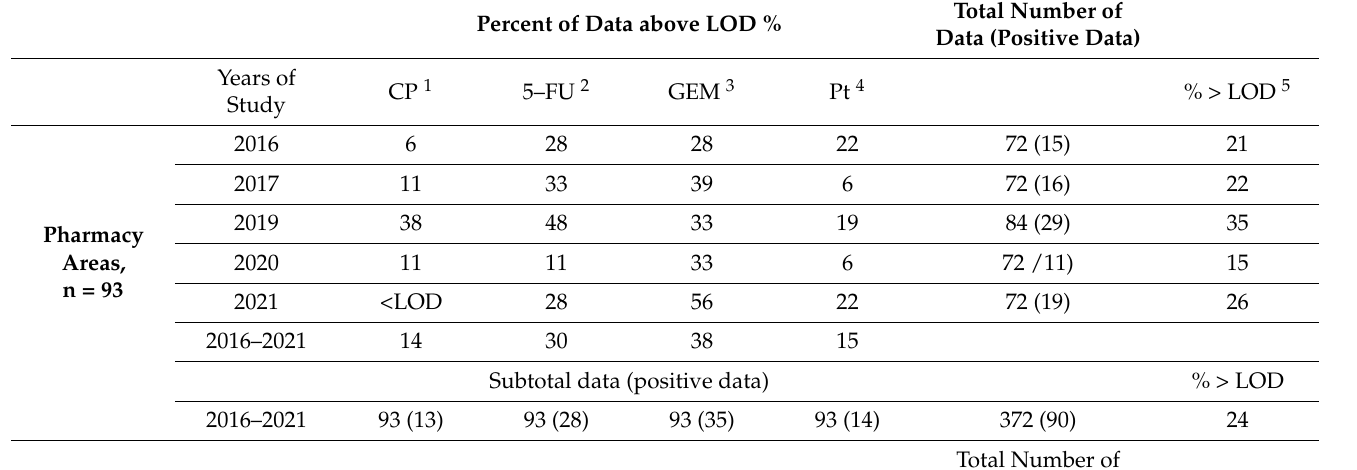
Table 3. Frequency of contamination for each drug throughout the years of study in pad samples. Percent of Data above LOD